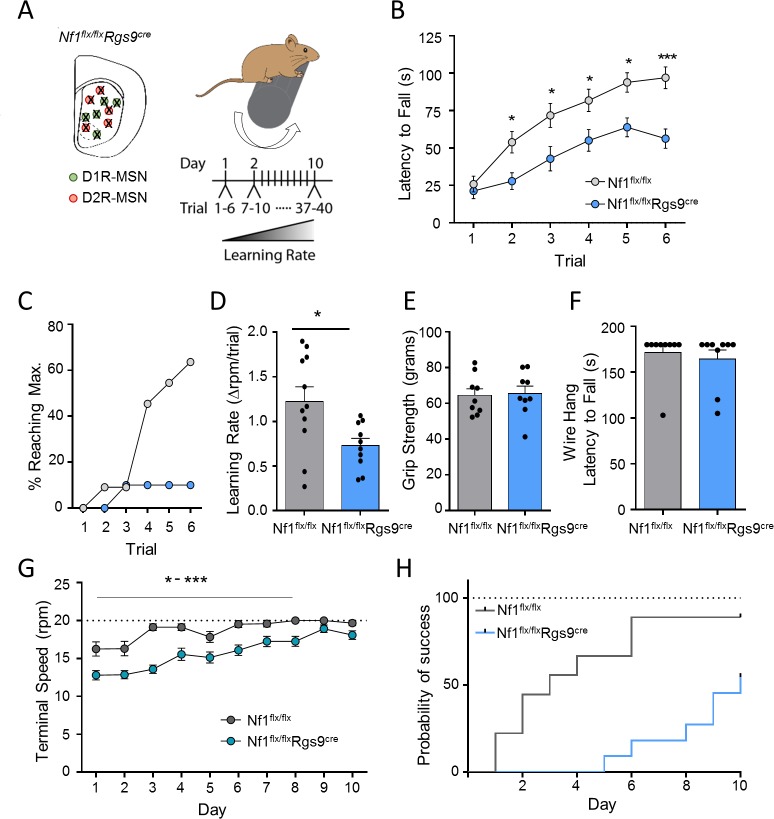
Key role of striatal NF1 in motor learning.(A) Scheme of NF1 deletion from MSNs and accelerating rotarod paradigm. (B) Performance of Nf1flx/flx and Nf1flx/flxRgs9cre mice on the accelerating rotarod. n = 14 mice/group, two-way RM ANOVA. (C) Percentage of mice able to reach maximal speed. (D) Learning rate of Nf1flx/flx and Nf1flx/flxRgs9cre mice on the accelerating rotarod. Student t test. (E) Grip strength and (F) wire hang for Nf1flx/flx and Nf1flx/flxRgs9cre mice. n = 9 mice/group. (G) Time course of the terminal speed (trial 4) over 10 days of consecutive training on the accelerating rotarod for Nf1flx/flx and Nf1flx/flxRgs9cre mice. n = 8–13 mice/group, two-way RM ANOVA. (H) Probability of reaching maximal speed over the 10 days of training on the accelerating rotarod. Data are represented as mean ± SEM. *P < 0.05, ***P < 0.001. Underlying data for this figure can be found in S1 Data. MSN, medium spiny neuron; NF1, neurofibromin 1; RM-ANOVA, repeated measures analysis of variance.